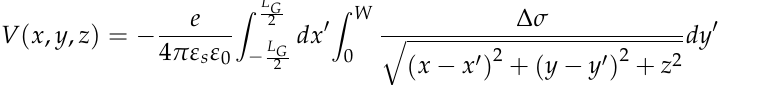
ε s is the static dielectric constant of GaN, ε 0 is the vacuum dielectric permittivity. Here, the PCF scattering potential is dominated by the additional polarization charges ∆ σ . The larger the ∆ σ , the larger the PCF scattering potential. Here, ∆ σ TFSI is smaller than ∆ σ , therefore the device with TFSI treatment presents weaker PCF